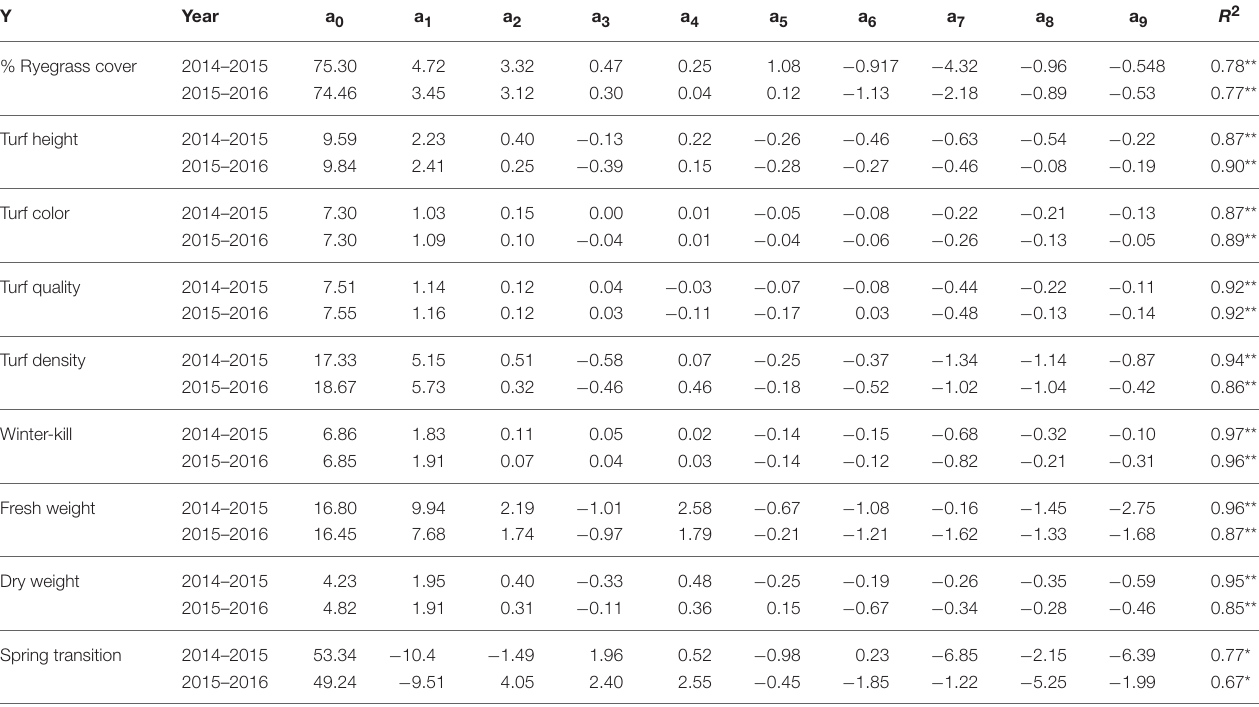
TABLE 4 | Parameter coefficients of the regression equation ( Y = a 0 + a 1 x 1 + a 2 x 2 + a 3 x 2 + a 4 x 1 x 2 + a 5 x 1 x 3 + a 6 x 2 x 3 + a 7 x 2 1 + a 8 x 2 2 + a 9 x 2 3 ) for % ryegrass